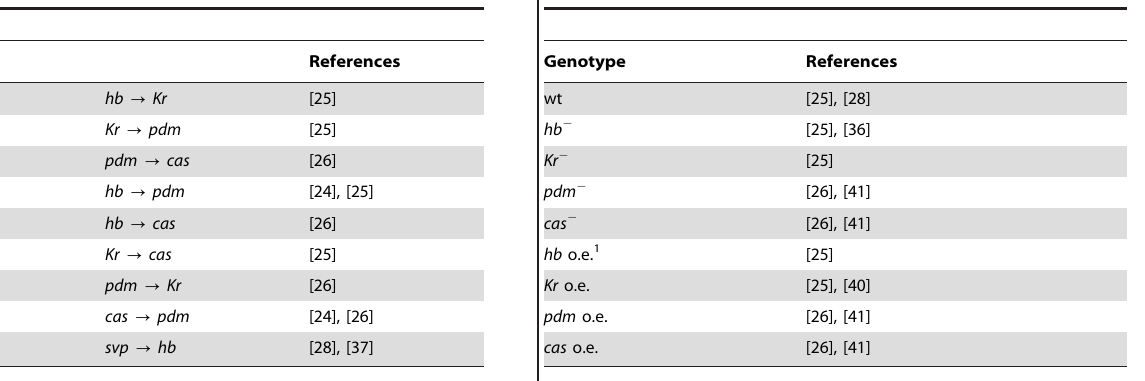
Table 1. List of the regulatory interactions of the genes in the NB temporal patterning network.